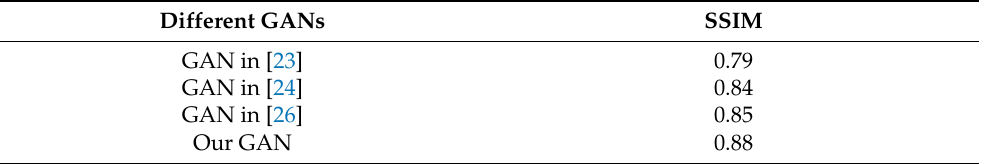
Table 9. Some comparative experiments with other GAN